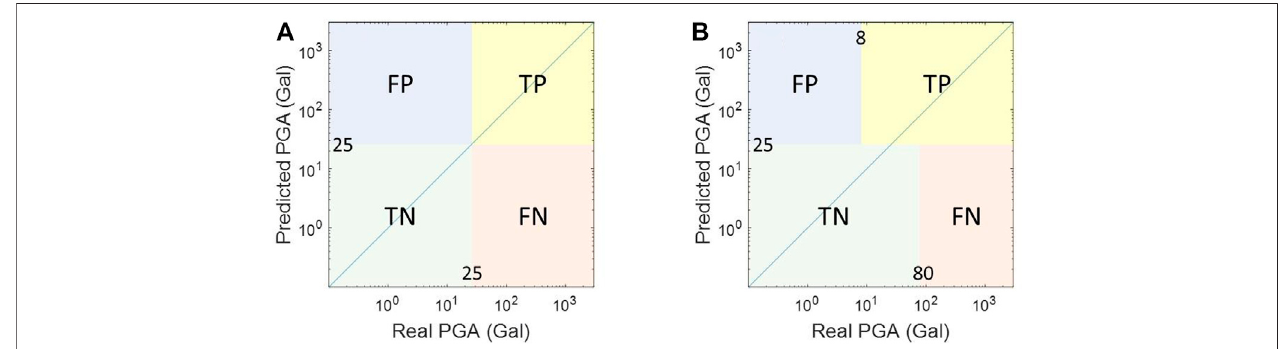
FIGURE5| Theconfusionmatrixwhenthethreshold isdesignatedas25 Gal (A) withouttolerance,and (B) withtolerance.FPisfalsepositive;FNisfalsenegative; TP is true positive; and TN is true negative.